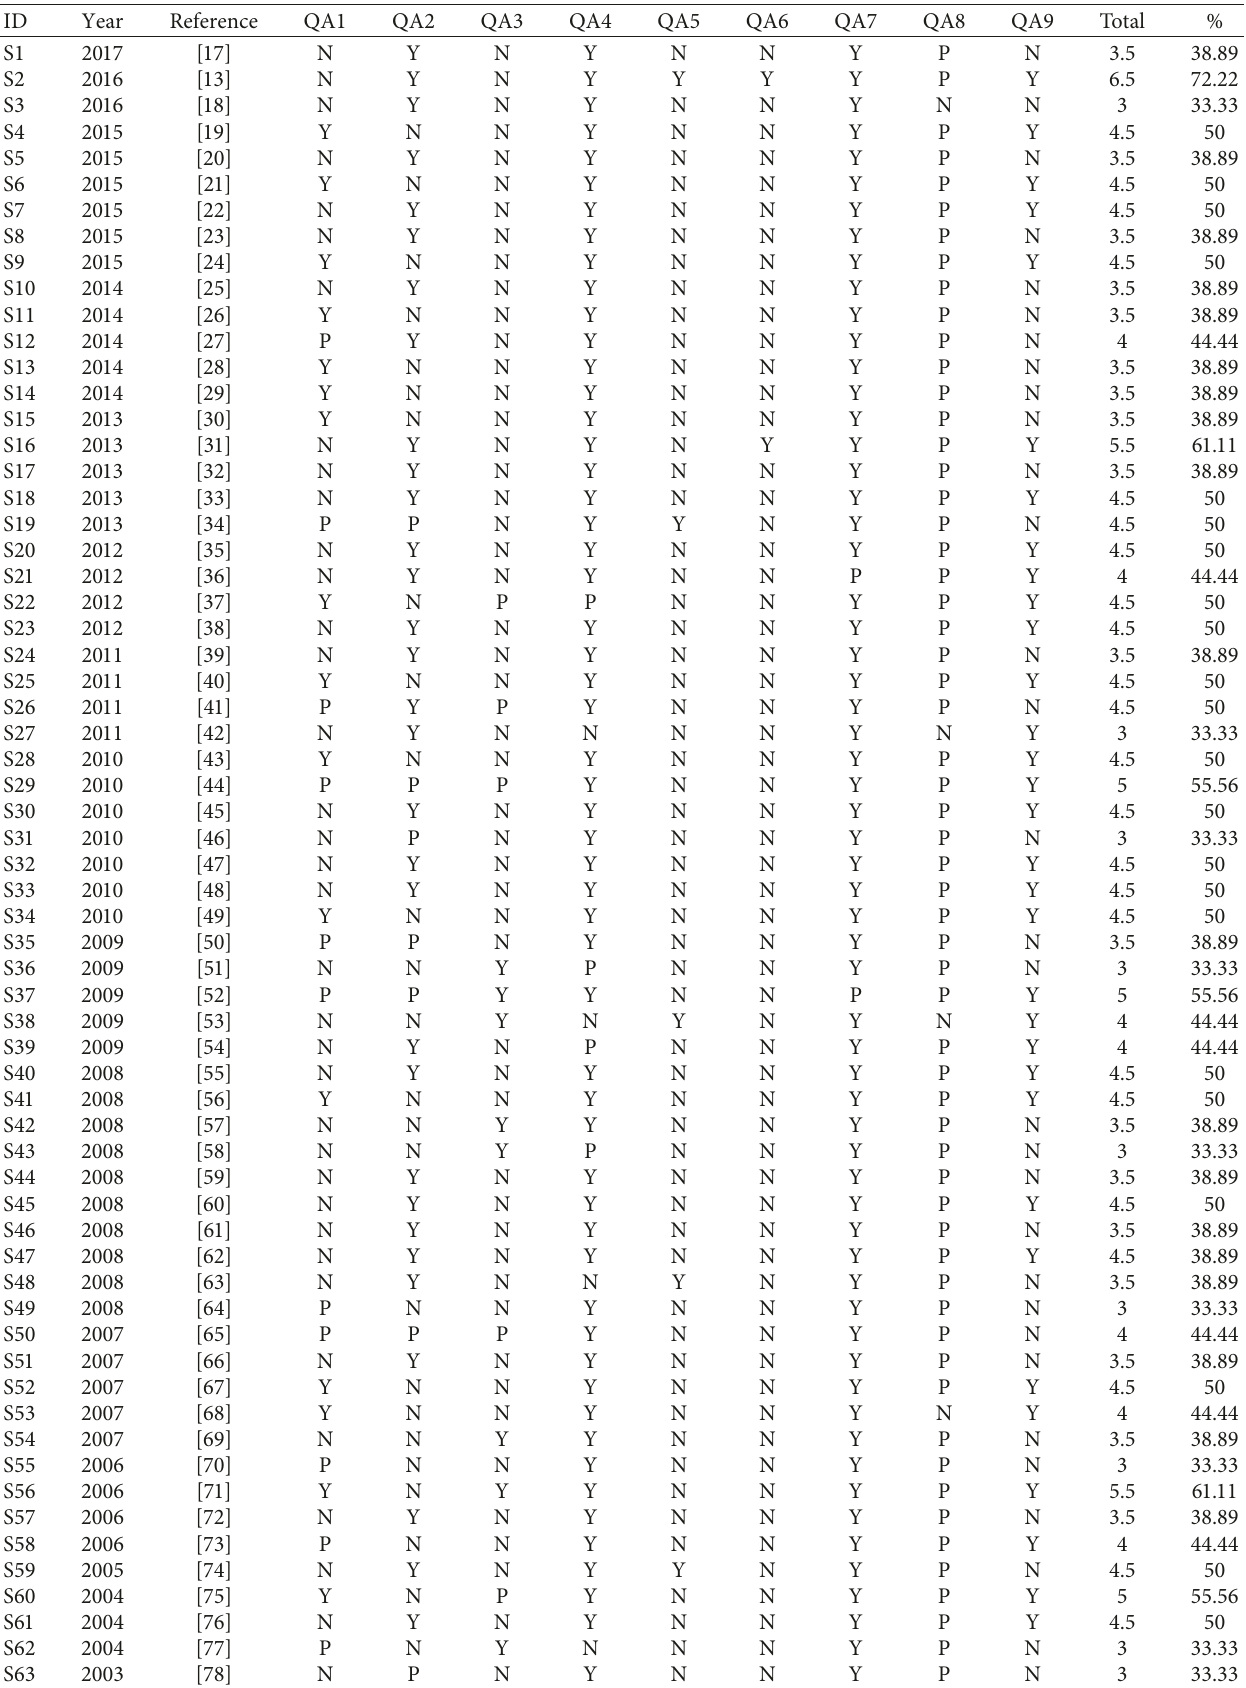
Table 3: Quality assessment